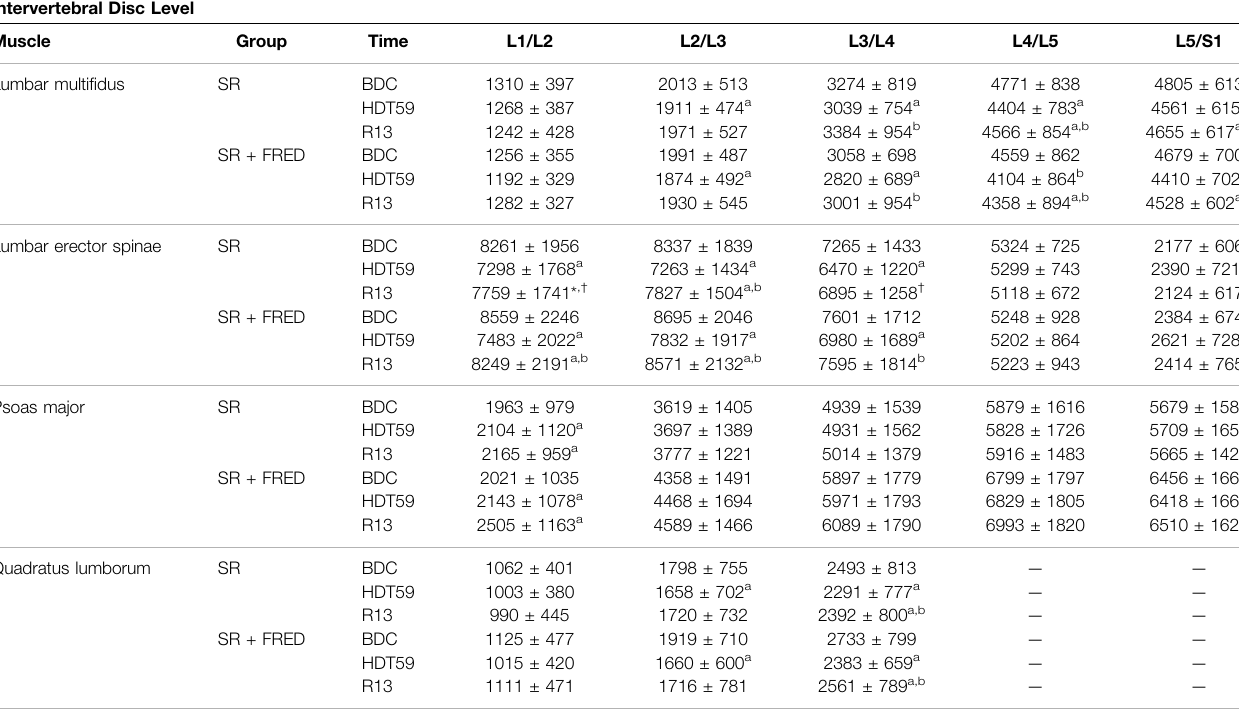
TABLE 2 | Mean (± standard deviation) muscle volume in mm 3 from SR ( N = 12) and SR + FRED ( N = 12) at BDC2, HDT59, and